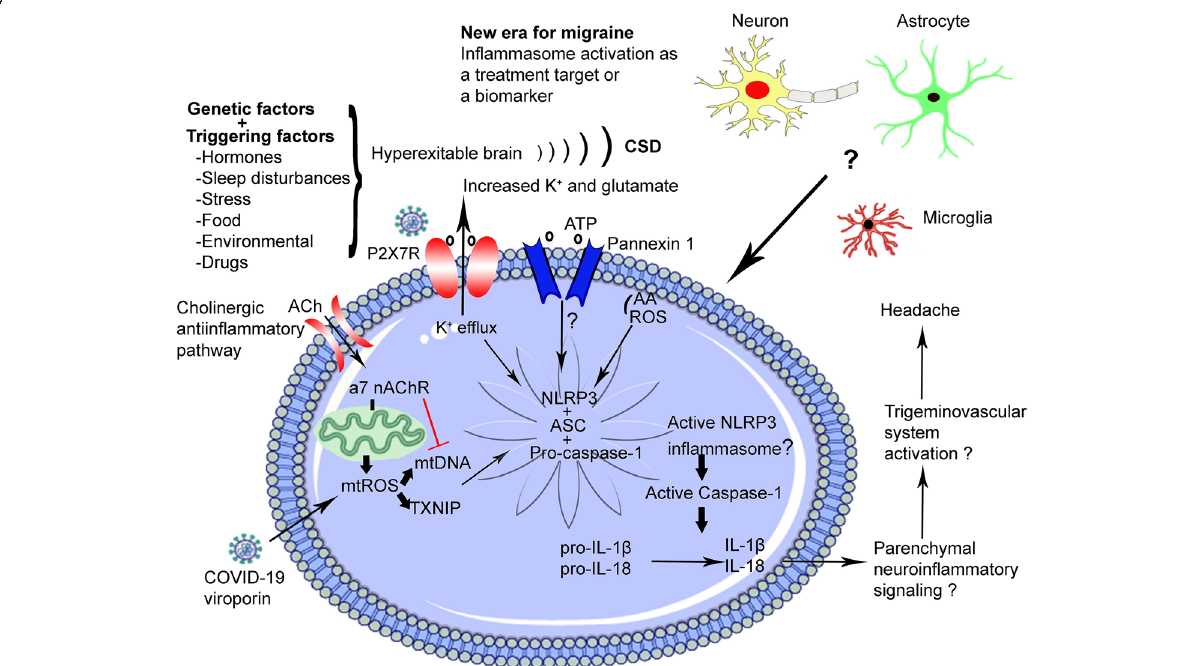
Fig. 2 New era for migraine: Inflammasome activation as a treatment target or a biomarker. In the background of genetically hyperexcitable brain, triggering factors induce CSD which results in Pannexin-1 megachannel opening and K + efflux from P2X7R, consequently creates stress on the cell. Reactive oxygen species (ROS) from membranous Arachidonic acid (AA) and mitochondria respond to this cellular stress via mtROS production which is sensed by mtDNA and TXNIP. K + efflux, mtDNA and Pannexin-1 megachannel opening cause the assembly of inflammasome complex elements (NLRP3, ASC, pro-caspase-1) and activation of caspase-1 which cleaves pro forms of IL-1 β and IL-18 and ignites parenchymal neuroinflammatory signaling to alert adjacent cells. This cascade eventually reaches the trigeminovascular system around meningeal vessels which results in activation of this system and consequently headache. COVID-19 viroporins induce NLRP3 inflammasome formation via increase in mitochondrial ROS production. This may be an overlapping mechanism in migraine and COVID-19 headache. On the contrary, ACh, main actor in cholinergic anti-inflammatory pathway, inhibits NLRP3 inflammasome by decreasing mtDNA release through binding to mitochondrial α 7